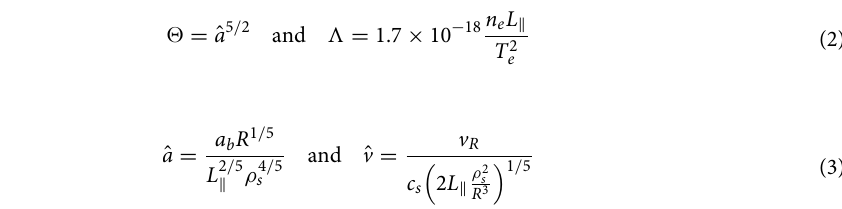
ˆ a and ˆ v are the blob’s normalized radius and radial speed, respectively. Here, n e and T e are the local electron density and temperature, respectively, L (cid:31) is the parallel connection length, a b is the blob radius, R is the major radius of the tokamak, ρ s is the ion sound Larmor radius, v R is the radial speed of the blob, and c s is the sound speed. Our blob-tracking models allow us to estimate a b and v R . Other plasma parameters are measured using other diagnostics. There are four regimes in the diagram, named “resistive ballooning” (RB), “resistive X-point” (RX), “connected ideal-interchange” ( C i ), and “connected sheath” ( C s ). Theory predicts different scaling relationships between the normalized radial speed ( ˆ v ) and the radius ( ˆ a ) of the blob depending upon regime (see Fig. 7). We have evaluated (cid:31) and (cid:31) for two different plasma conditions (Plasma 1 and Plasma 2) using a traditional method (CAS) and our four blob-tracking models (RAFT, Mask R-CNN, GMA, and Flow Walk). This evaluation locates the two plasmas within the theory-defined regimes, as shown in Fig. 7. We identify plasma 1 and 2 as being within C s and RX regimes, respectively, unanimously by four methods (CAS, RAFT, Mask R-CNN, and GMA) except Flow Walk. The closeness of the data points between the traditional method and the blob-tracking models